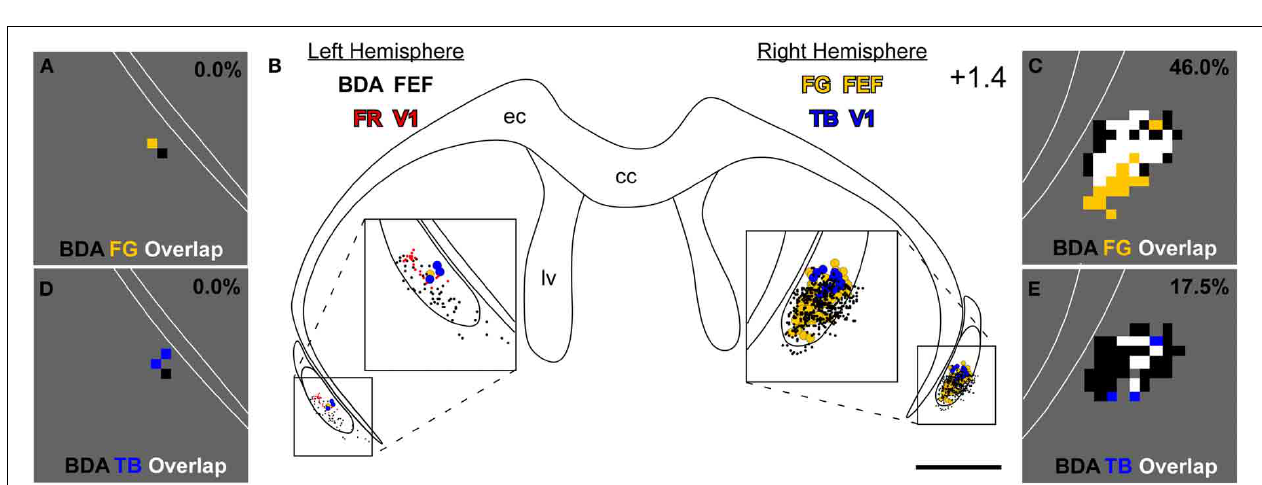
and green dots are double-labeled neurons. Black arrows indicate areas in (C,E) . (E) Confocal image of multiple retrogradely-labeled neurons in the right CLA. Red arrowheads in (C,E) indicate double-labeled neurons, white arrowheads indicate TB-labeled neurons. Scale bars: 500 µ m in (A) ; 50 µ m in (C) ; 1mm in (D) .